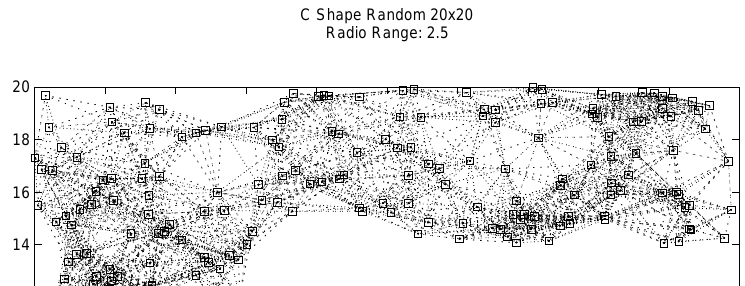
Figure 6. Example of C-shape network topology.